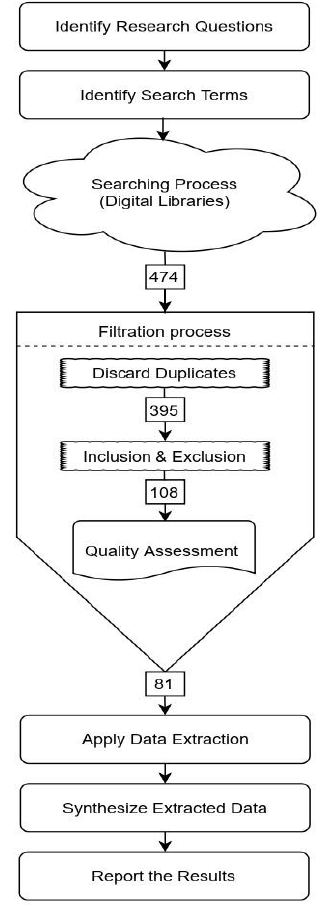
Figure 2 Research